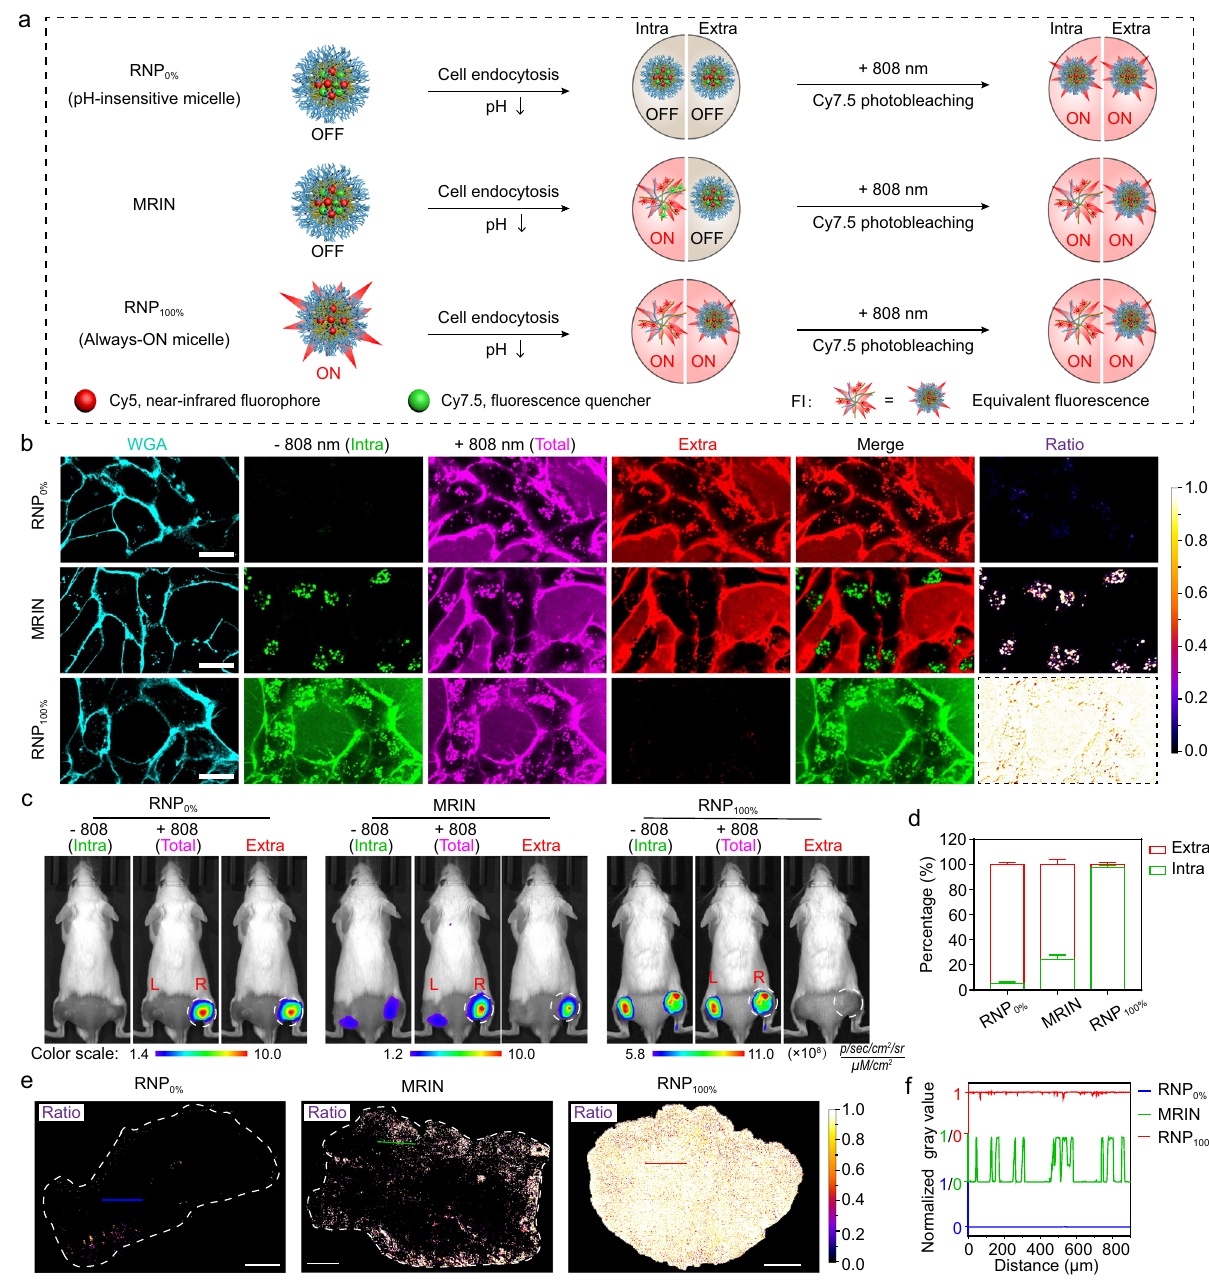
Fig. 3 Methodology of MRIN for quantifying intracellular and extracellular distribution of nanoparticles. a Schematic illustration of Cy5 fl uorescence ampli fi cation for RNP 0% , MRIN, and RNP 100% in response to sequential cellular endocytosis and 808 nm irradiation. b 4T1 cells were incubated with RNP 0% , MRIN, and RNP 100% at 37 °C for 0.5 h, respectively, then the cells were irradiated in situ with an 808 nm laser. The image of extracellular nanoparticles was calculated by subtracting the pre-irradiated Cy5 fl uorescence image from the post-irradiated Cy5 fl uorescence image, and the merged images were presented in pseudo-color green and red for intracellular and extracellular NPs, respectively. The ratio channel displayed the intracellular distribution of nanoparticles. The images of RNP 0% and RNP 100% before 808 nm irradiation were served as the extrapolated states of 0% and 100% internalization of nanoparticles. Scale bar = 20 μ m. c In vivo fl uorescence images of the bilateral 4T1 tumor-bearing mice with irradiation on right tumors at 24 h post-injection of RNP 0% , MRIN, and RNP 100% . The images of extracellular nanoparticles were obtained by subtracting pre-irradiated Cy5 fl uorescence images from post-irradiated Cy5 fl uorescence images. The circles indicate the irradiated right tumors. d The percentage of intracellular and extracellular nanoparticle exposure from Fig. 3c ( n = 4 biologically independent mice). e The ratiometric fl uorescence images of intracellular nanoparticles versus total distributed nanoparticles in tumor sections at 24 h post-injection. f The values of ratiometric signal indicate endocytic events cross the corresponding line in Fig. 3e, value “ 1 ” and “ 0 ” represent endocytic NPs and non-endocytic NPs, respectively. All data were presented as mean ±